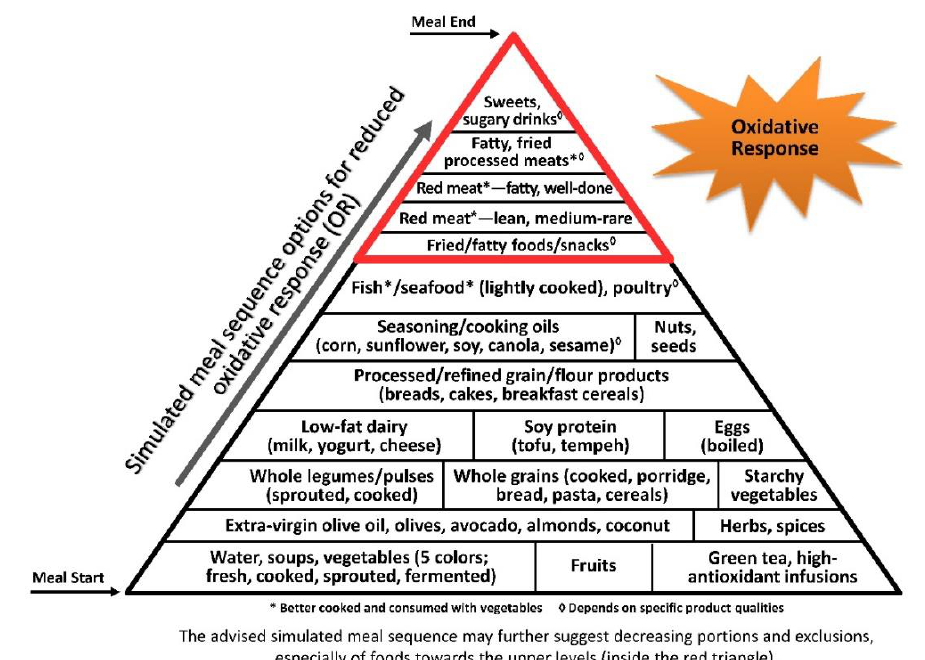
Figure 3 Figure 3. The Meal Sequence Pyramid per Oxidative Response (OR) Axis. Foods are ranked according to their potential to enhance reactive oxidation species (ROS) postprandially. Foods at the bottom of the pyramid have the lowest OR, being the least oxidizable and highest in antioxidants that neutralize ROS, and are recommended for starting the meal and preparing early protection against OR from ensuing courses; the next levels include relatively whole, minimally processed foods low in oxidative compounds, further contributing to a moderate OR; and the highest levels include highly processed foods through technologies that generate high amounts of ROS, with little-to-no antioxidant content, and foods high in pro-oxidative potential like fried foods and high-iron red meat, therefore contributing to the sharpest OR, and should be delayed to the end of the meal (if consumed at all), after the body has been primed with attenuating antioxidative cascades from earlier